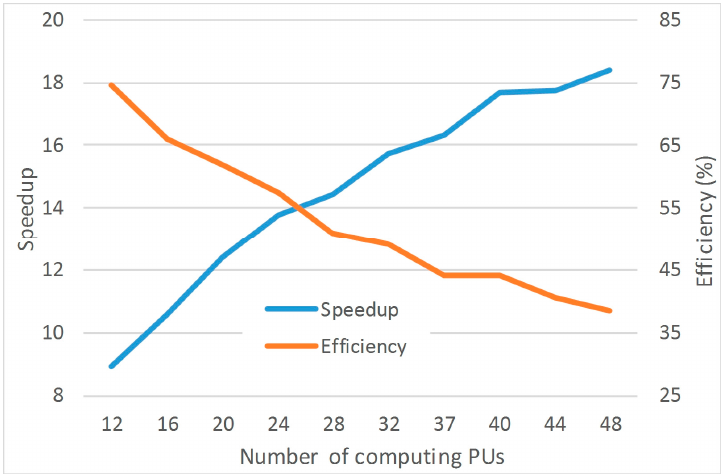
Figure 11. Speedup and efficiency of beamforming implementation.